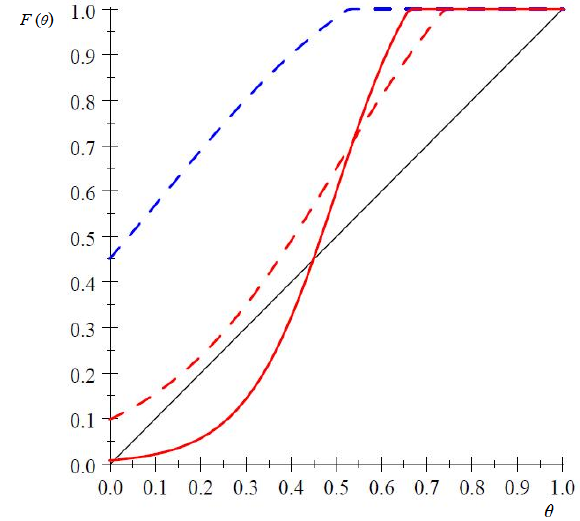
Figure 8. Fixed points for coordination in morally heterogeneous